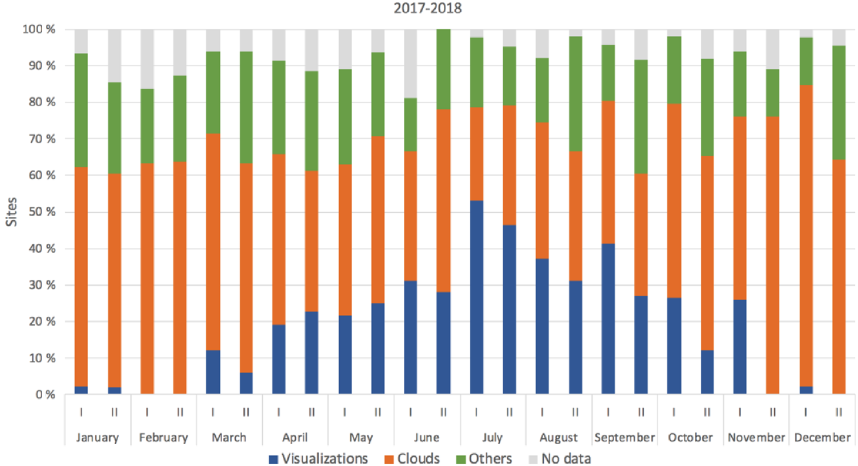
Figure 3. Percentage of successful and unsuccessful SGD identifications for all SGD springs that were identified at least once (23 springs representing 44%) throughout the year 2017 and during the year 2018 (based on the selection of 720 images) are shown individually in the Supplement 3. The x axis shows the months of the year. Roman numerals (I and II) represent the two satellite passes per month that cover every area. No image available is represented in gray, while the presence of clouds is in orange and blue for successful SGD identifications. Those for which the images were not covered by clouds, and where SGD springs were not identified, are shown in the figure as “others” in